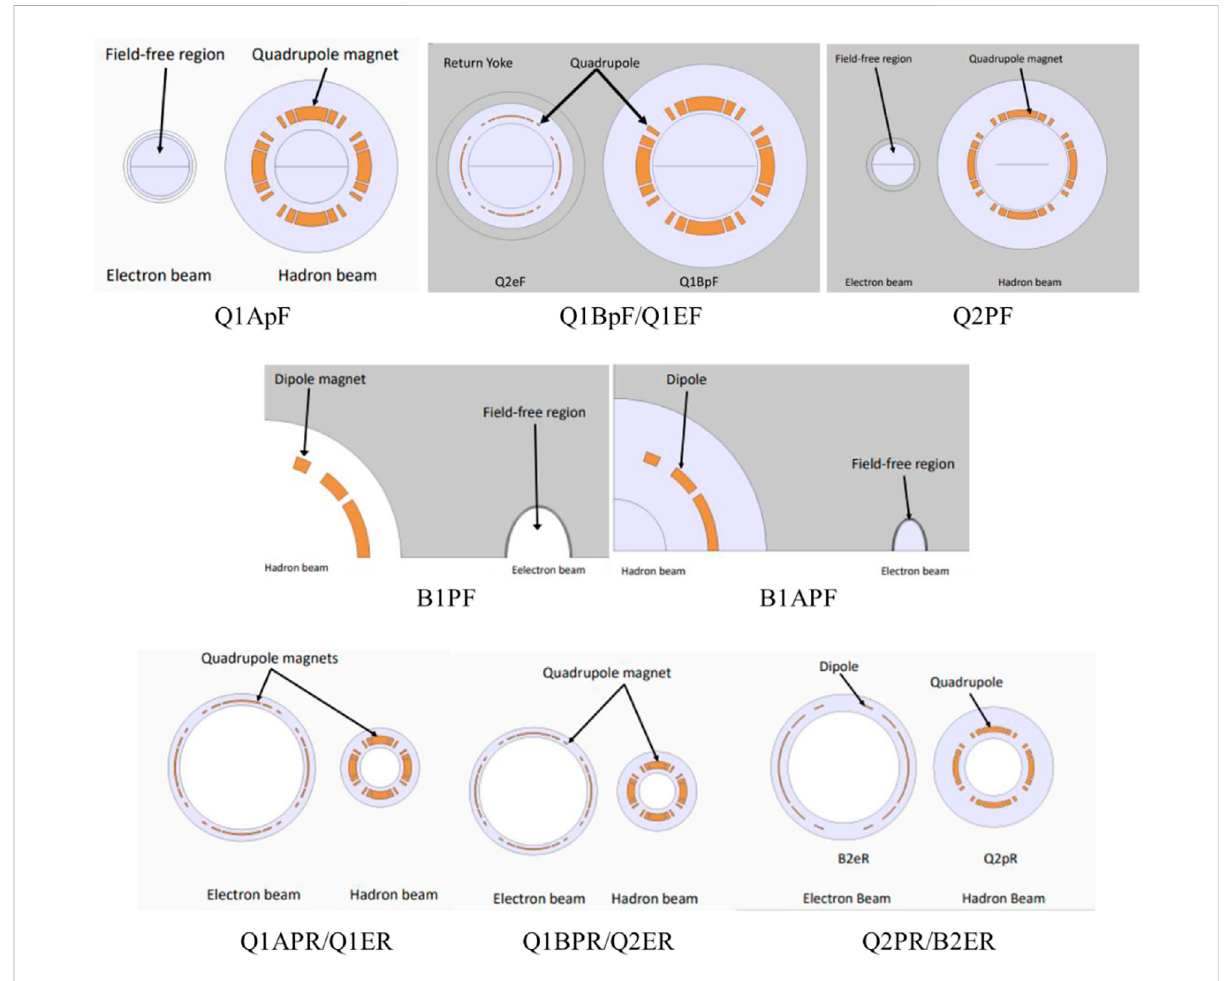
FIGURE 5 Cross-sections of IR1 superconducting magnets.